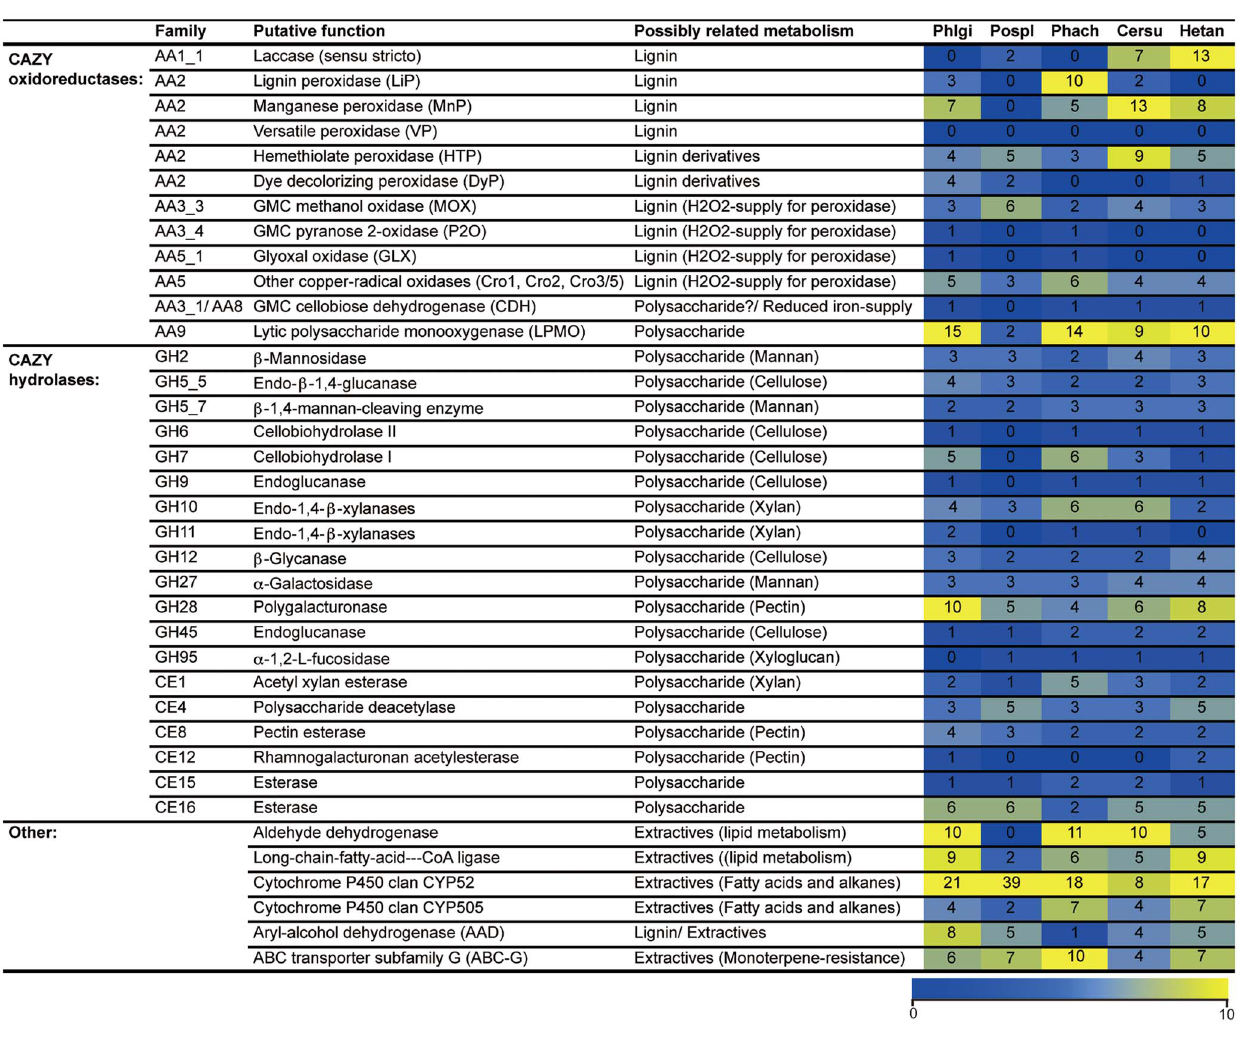
Figure 4. Number of genes identified in white rot fungi P.gigantea (Phlgi), P.chrysosporium (Phach)[27], C.subvermispora (Cersu)[22], and H.annosum (Hetan)[75], and the brown rot fungus P.placenta (Pospl)[45]. CROs were distinguished as previously described [76]. Lytic polysaccharide monooxygenases were formerly classified as GH61 within the CAZy system ( http://www.cazy.org/ ; [16]). Glycoside hydrolase family GH5 was subdivided as described [77] (Figure S22).